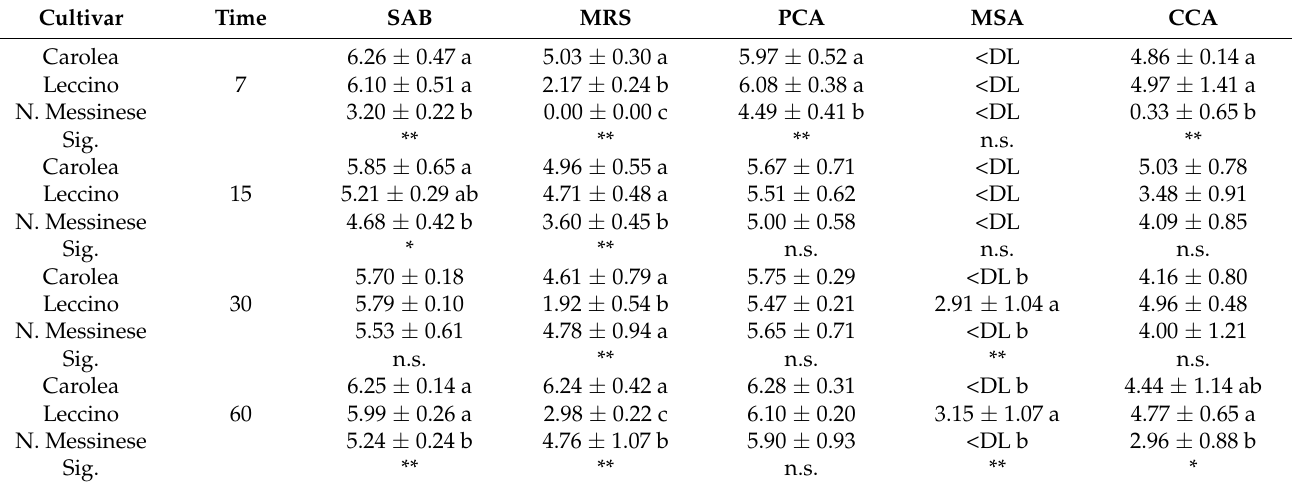
Table 6. Microbial log counts of yeasts and moulds (SAB), lactic acid bacteria (MRS), total viable count (PCA), staphylococci (MSA) and coliform bacteria (CCA) growth in Spanish-style olive